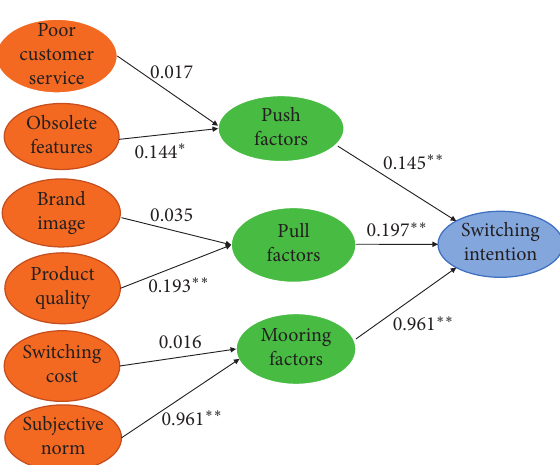
Figure 2: Estimated proposed structural equation model. Note: ∗ and ∗∗ indicate significance of p values at 0.05 and 0.01,